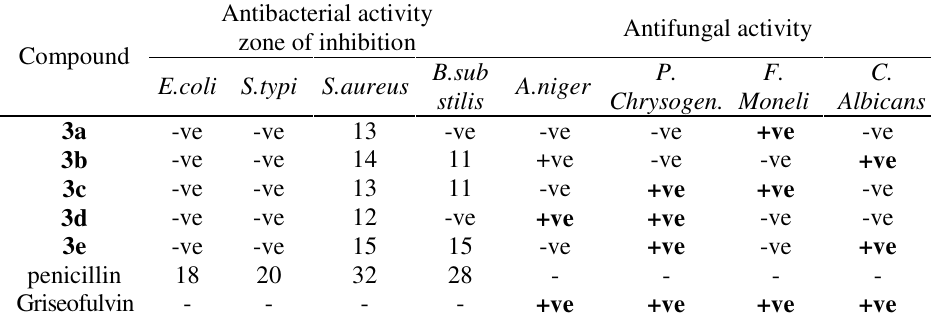
Table 3. Antimicrobial activity of synthesized compounds Antibacterial activity zone of